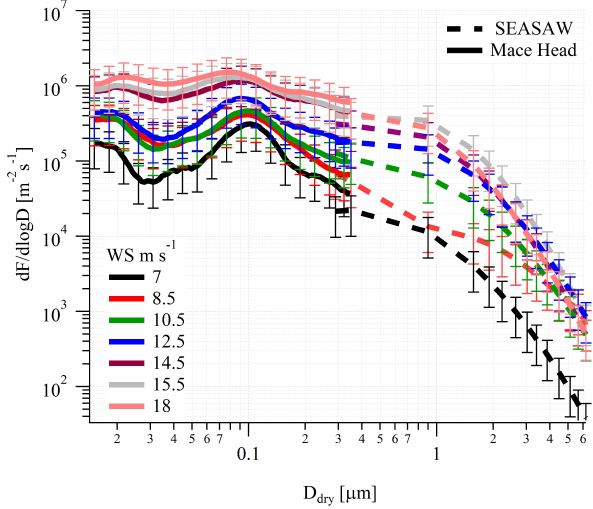
Fig. 3. dF/dlogD at different wind speeds: solid lines represent Mace Head data and dashed lines represent SEASAW measure- ments, error bars represent measurement and method uncertainties described in the Sect.